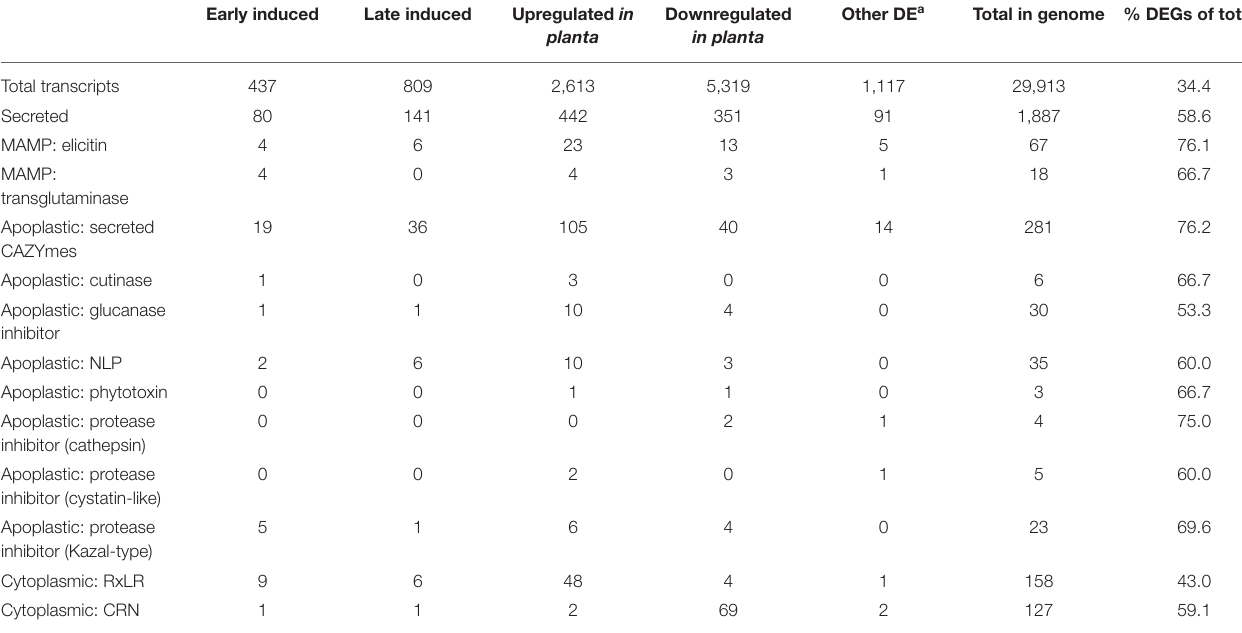
TABLE 5 | Expression profile of effector